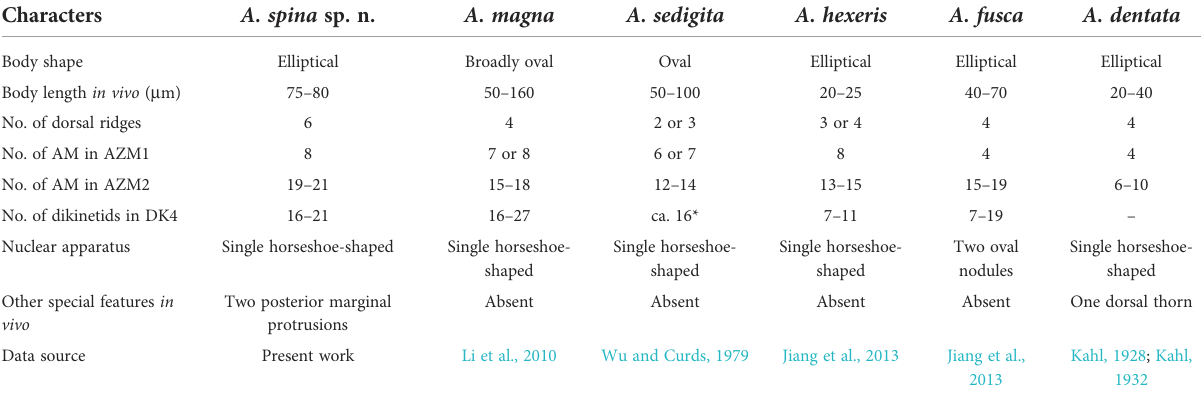
TABLE 2 Comparison of Aspidisca spina sp. n. with some congeners having peristomial spur and seven frontoventral cirri in “ polystyla- arrangement ”